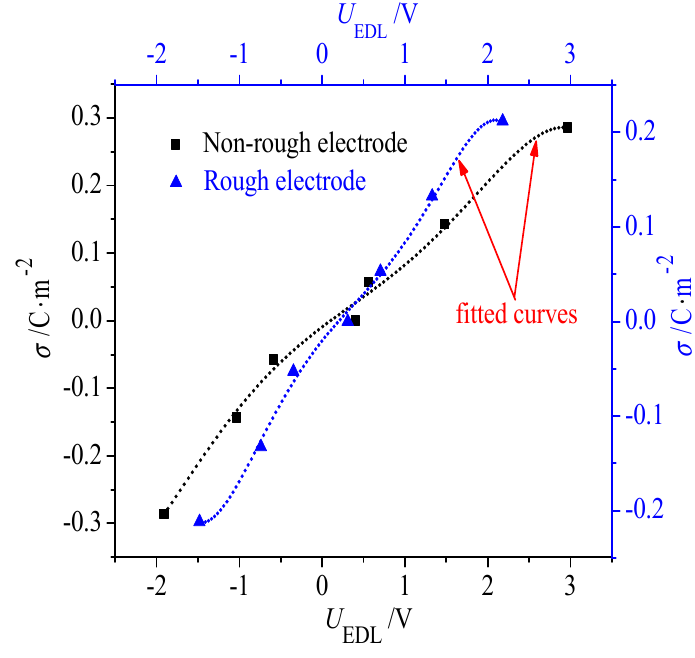
Figure 8. Correlation between the electrode charge density and the potential drop across the electrical double layers (EDLs) on the non-rough and rough electrodes.